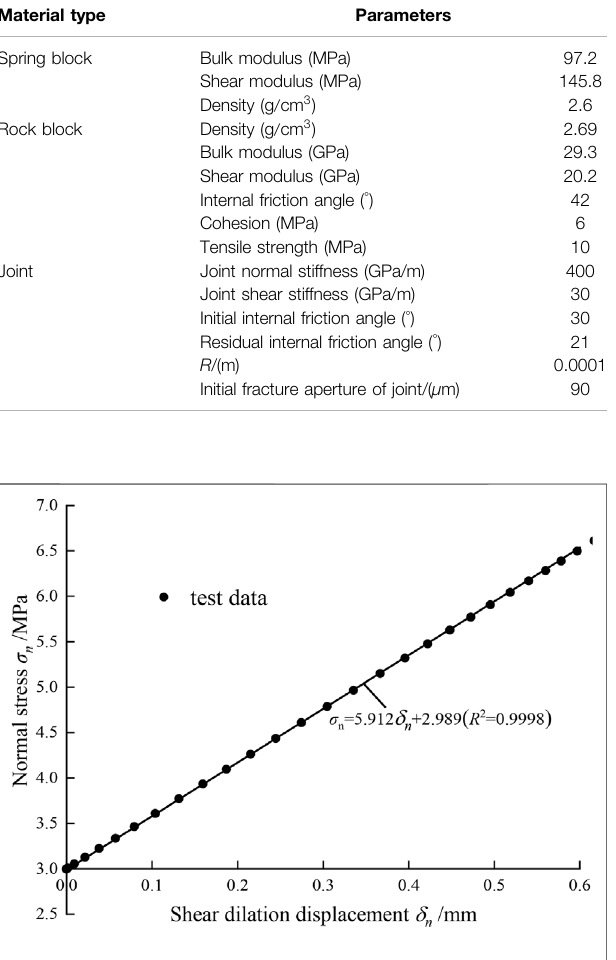
12.481 (rough), 15.241 (very rough), and 18.244 (very rough) in Figure 1 were selected. The rough joints were digitized in AutoCAD software and imported into the numerical model by “ crack